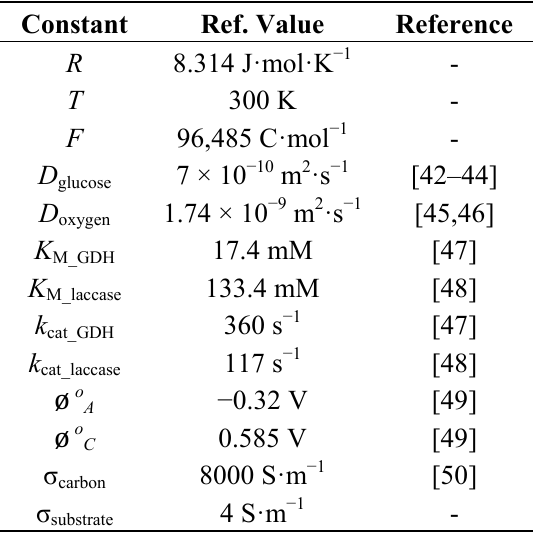
Table 2. Simulation